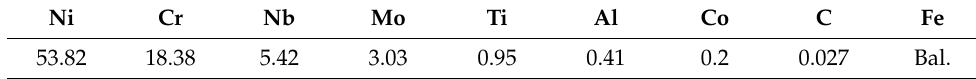
Table 1. Chemical composition (wt.%) of the studied superalloy. Ni Cr Nb Mo Ti